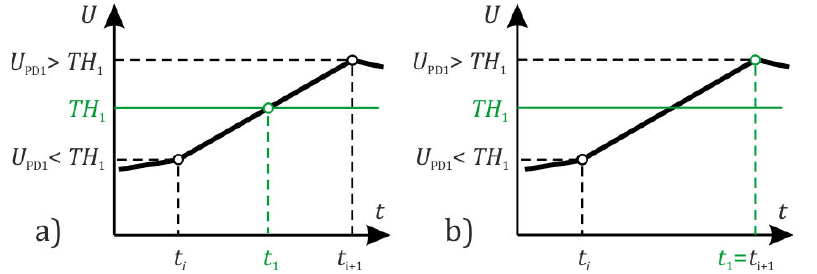
Figure 14. Determination of the detected moments at which the signal exceeds the threshold ( a ) with and ( b ) without